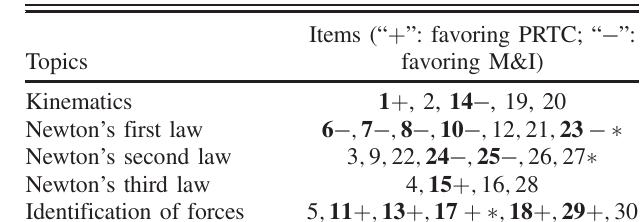
TABLE III. Categorization of the FCI items and detected DIFs (in bold prints). “ þ ” indicate items in favor of the PRTC course, and “ – ” indicate items in favor of the M&I course. “ (cid:2) ” indicate items with DIF in the